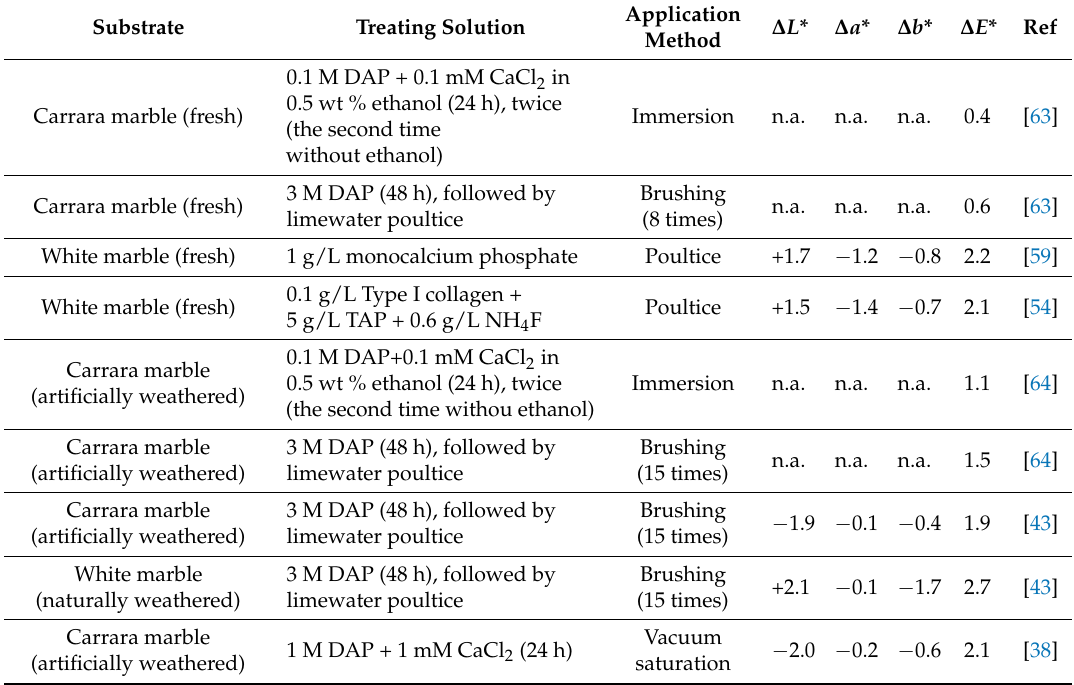
Table 5. Colour change in marble after the phosphate treatment ( L * = black ÷ white, a * = green ÷ red, b * = blue ÷ yellow, ∆ E * = colour change, n.a. = not